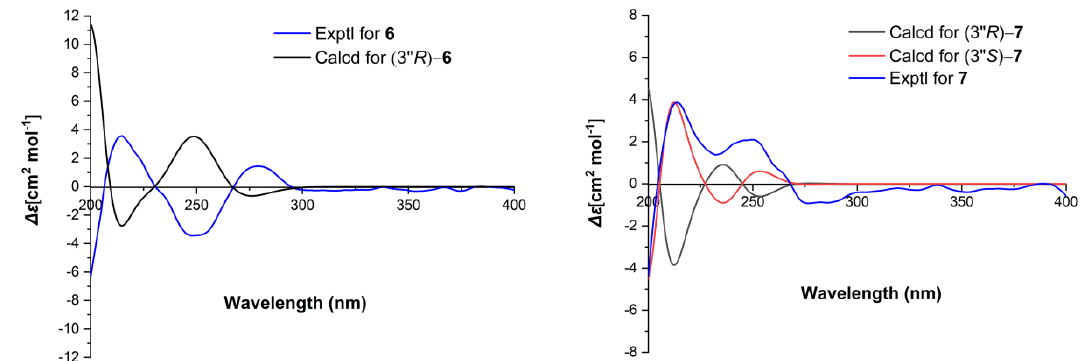
Figure 4. Comparison of the calculated ECD spectrum for (3 ″ R ) – 6 with the experimental spectrum of 6 at B3LYP/6-31(d,p) level in MeOH (left). σ = 0.3 eV, shift = +5 nm. Comparison of the calculated ECD spectra for (3 ″ R ) – 7 and (3 ″ S ) – 7 with the experimental spectrum of 7 at B3LYP/6-31(d,p) level in MeOH (right). σ = 0.16 eV, shift = 0 nm.